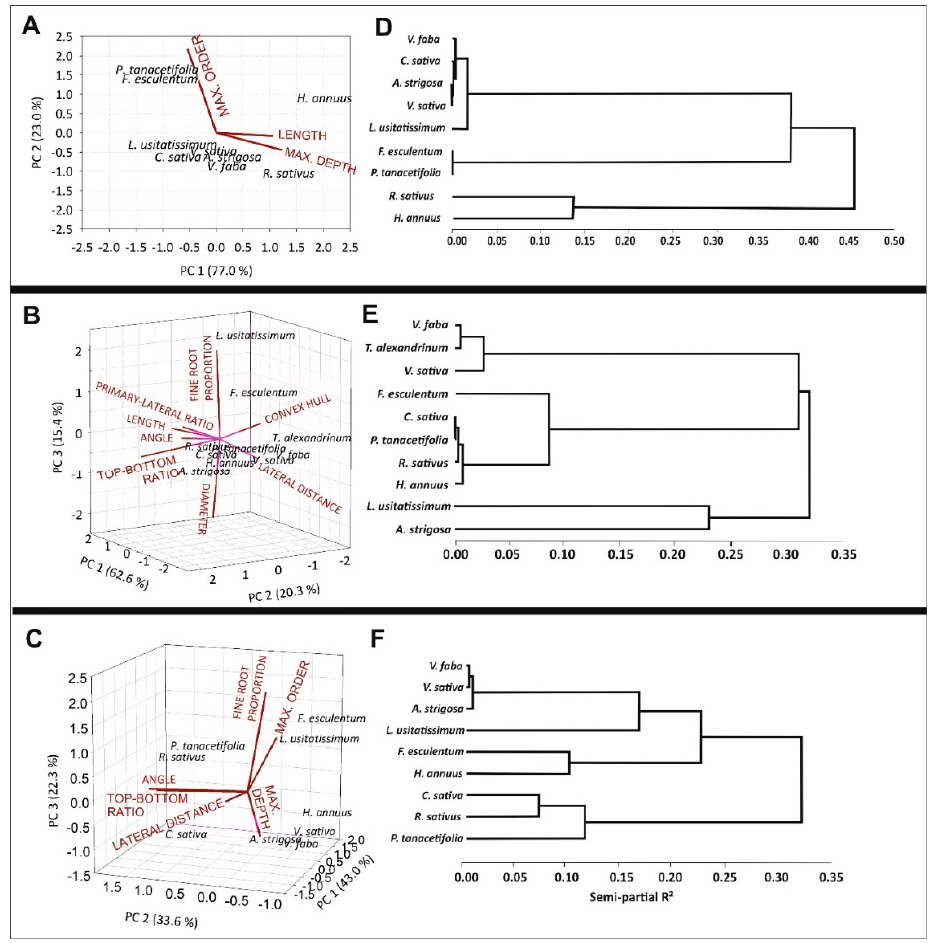
Figure 2. Biplots from principal component analysis (left; A – C ) and dendrograms from cluster analysis (right; D – F ) for cover crops using ( A , D ) Root Atlas data only ( T. alexandrinum not described in Root Atlas), ( B , E ) morphological and architectural root traits obtained from rhizobox imaging, and ( C , F ) lower-level root traits integrating rhizobox imaging and Root Atlas data. The biplots visualize trait vectors (red lines; similar vector direction indicates correlation among traits; vector length indicates trait importance for building the principal components) and location of genotypes according to principal component scores. See Tables 1–3 for trait description. Dendrograms cluster the cover crop species into distinctive groups based on their root principal component scores. Clusters with small semi-partial R 2 show high homogeneity in their rooting